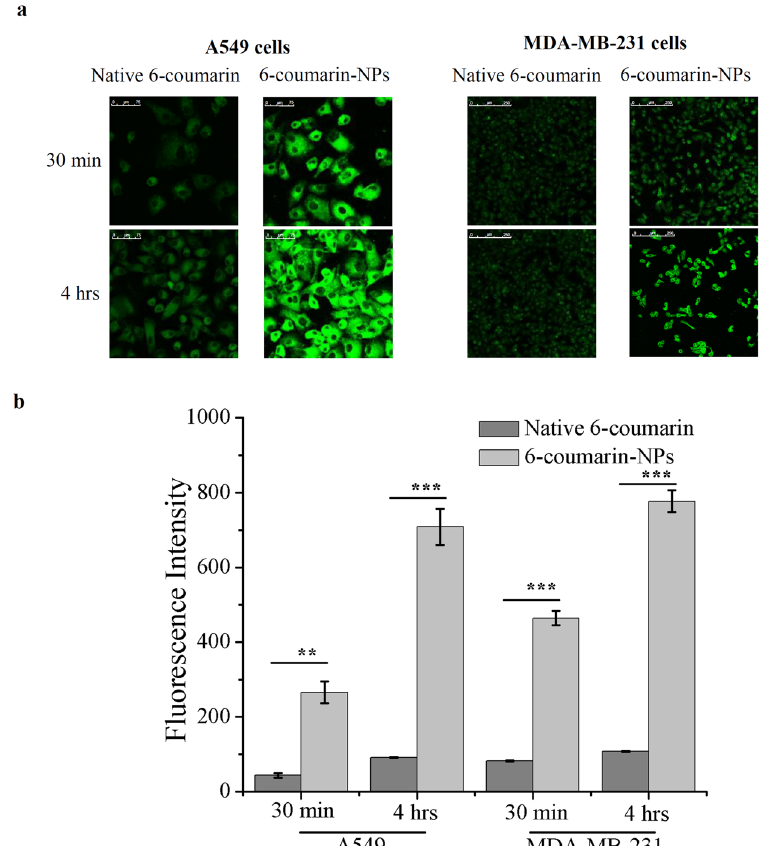
Figure 2. Cellular uptake study of Native 6-coumarin, 6-coumarin-NPs in different cell lines by confocal microscopy and fluorescence spectrophotometer. ( a ) Qualitative cellular uptake study of Native 6-coumarin and 6-coumarin-NPs (50 ng/ml) after 0.5 hr and 4 hrs of incubation in A549 and MDA-MB-231 cells by confocal microscopy. The experiment was done three times and a representative image is provided. ( b ) Quantitative cellular uptake study of Native 6-coumarin and 6-coumarin-NPs (40 ng/ml) after 0.5 hr and 4 hrs of incubation in A549 and MDA-MB-231 cells by fluorescence spectrophotometer (Values are as mean ± SEM, n = 3, ** p < 0.001, *** p < 0.0001 6-coumarin-NPs vs. Native